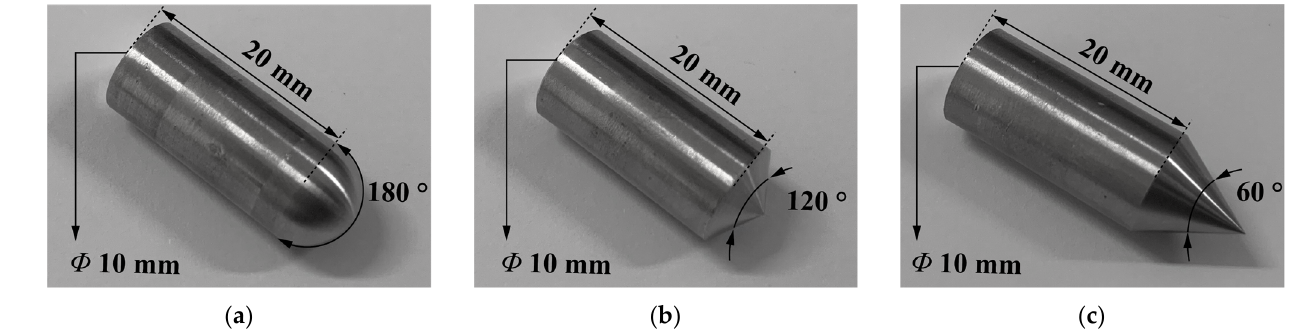
Figure 1. The different impact block shapes used in the experiment. ( a ) Hemispherical; ( b ) obtuse conical; ( c ) acute conical.